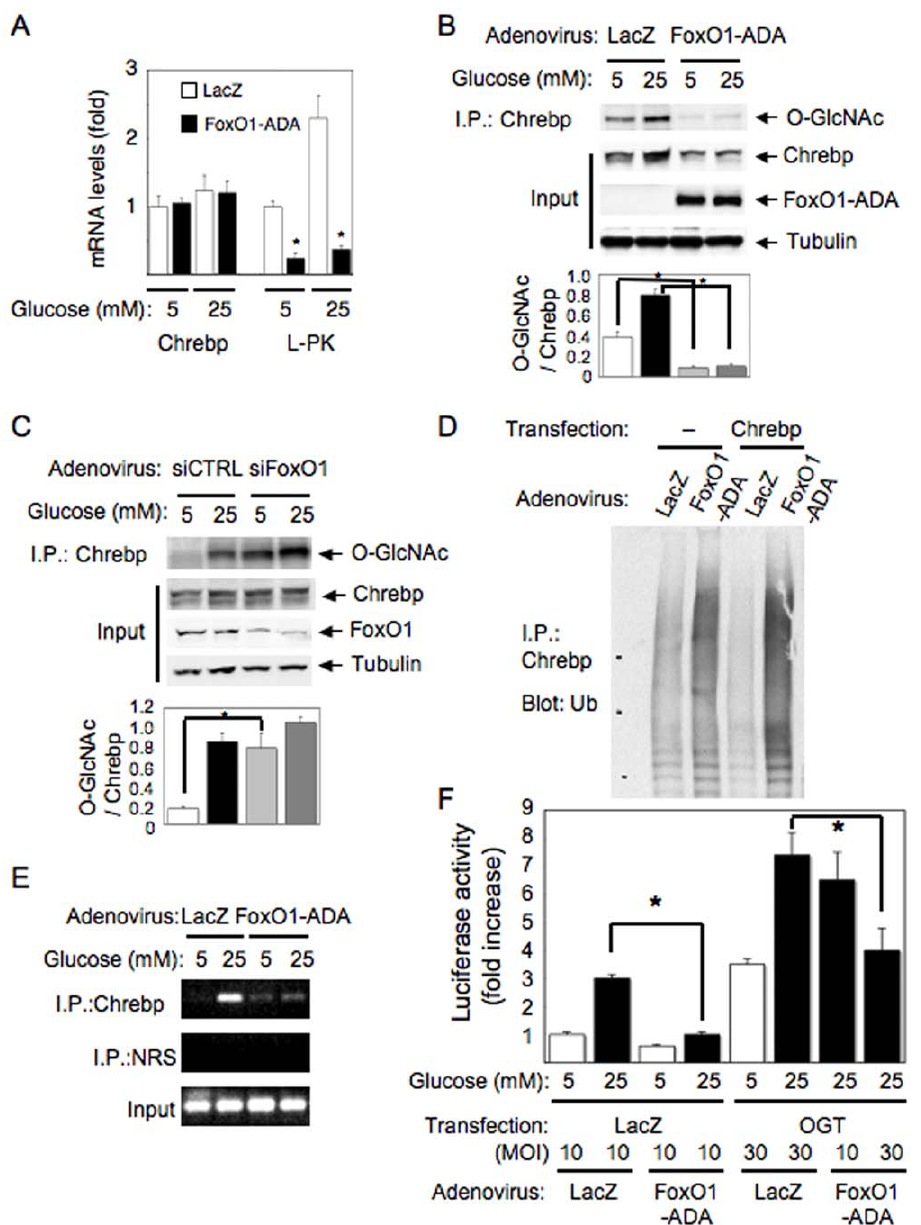
Figure 1. FoxO1-ADA expression and the knockdown of FoxO1 affect Chrebp O-glycosylation, protein stability and transcriptional activity in primary hepatocytes. (A, B, D and E) Mouse primary hepatocytes infected with adenovirus expressing FoxO1-ADA or LacZ were cultured with 5 mM or 25 mM glucose. The cell lysates were subjected to real-time RT-PCR for Chrebp or L-PK (A), immunoprecipitation with anti- Chrebp antibody followed by blotting with anti-O-GlcNAc antibody (B) or anti-ubiquitin antibody (D). The cell lysates were also subjected to chromatin-immunoprecipitation assay using anti-Chrebp antibody and the primers for L-PK promoter (E). (C) Mouse primary hepatocytes infected with adenovirus expressing specific siRNA for FoxO1 or control siRNA were cultured with 5 mM or 25 mM glucose and the cell lysates were immunoprecipitated with anti-Chrebp antibody followed by blotting with anti-O-GlcNAc antibody. Input represents expression levels of Chrebp, FoxO1-ADA, endogenous FoxO1 and Tubulin. Quantitative analyses were performed by assessment of O-glycosylation level compared with the protein level of Chrebp using densitometry, showing as a bar graph below the results of blotting (B and C). (F) Mouse primary hepatocytes co- transfected with pGL3-3Xl-PK-ChoRE and OGT or LacZ were infected with adenovirus expressing FoxO1-ADA or LacZ at indicated MOI and cultured with 5 mM or 25 mM glucose for 24 hr. The cell lysates were used for luciferase assays. Experiments were repeated at least three times. Data represent mean 6 SEM. *P , 0.05. Chrebp transcriptional activity (Fig. 1F). Taken together, these Chrebp O-glycosylation is regulated by OGT results show that FoxO1 inhibits Chrebp transcriptional activity by We used western blotting with anti-GlcNAc antibody to show suppressing O-glycosylation and reducing protein stability of that Chrebp is O-glycosylated in the presence of elevated glucose Chrebp. concentrations (Fig. 1B). To confirm the modification of Chrebp